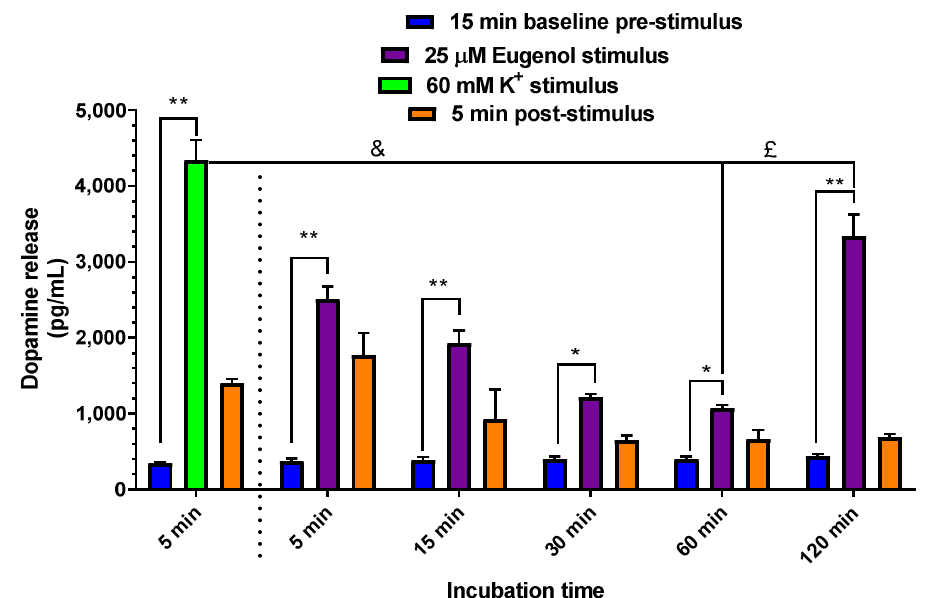
Figure 11. Time course of dopamine release from PC12 cells. PC12 cells were differentiated to the neuronal phenotype for 14 days, then stimulated with 60 mM K + KRH at 37 ◦ C for 5 min and with 25 µ M eugenol in KRH at 37 ◦ C for 5, 15, 30, 60 and 120 min. Each stimulation peak of release was compared to the respective pre-stimulation control or baseline release. Data are expressed as mean ± SE of three independent experiments, run in duplicate. Data were statistically analyzed by one-way ANOVA, followed by Bonferroni’s post-hoc multiple comparison test. * p < 0.05 stimulus vs. baseline. ** p < 0.001 stimulus vs. baseline. £ p < 0.05 60 mM K + vs. eugenol 120 min. & p < 0.001 60 mM K + vs. eugenol 60 min.